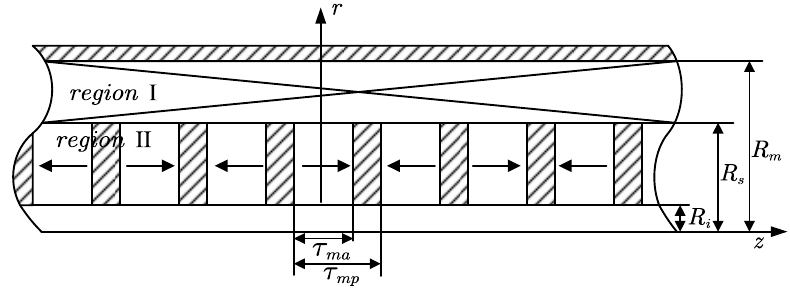
Figure 3. The magnetic computational regions of the MI-TLPMG.